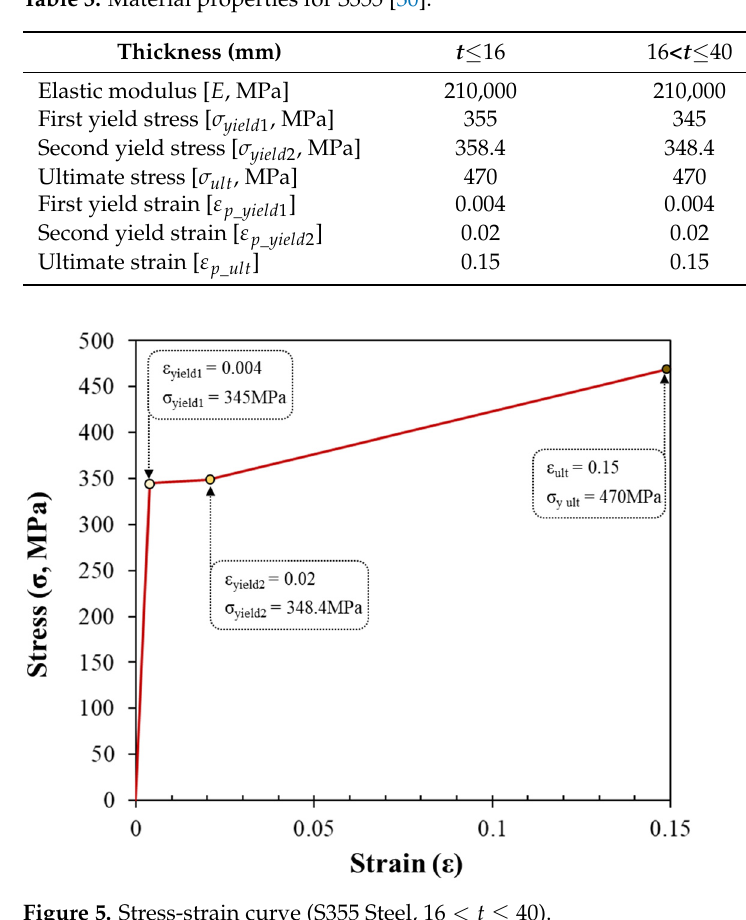
Figure 5. Stress-strain curve (S355 Steel, 16 < 𝑡 ≤ 40 ).